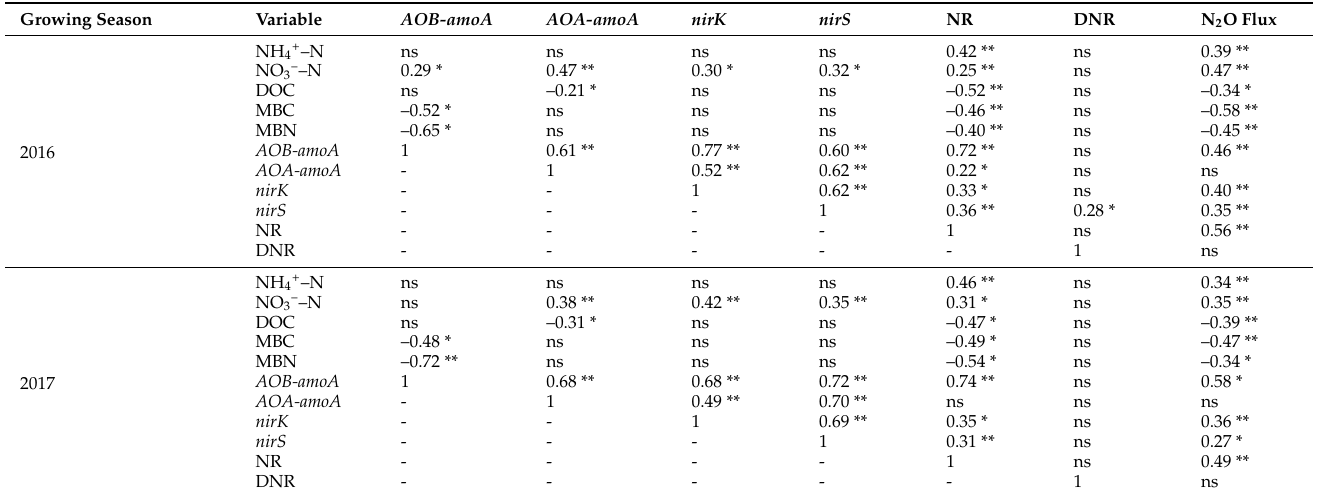
Table 4. Partial correlation coefficients among soil chemical properties, nitrifier/denitrifier abundance and nitrification/denitrification rates in two growing seasons of purple